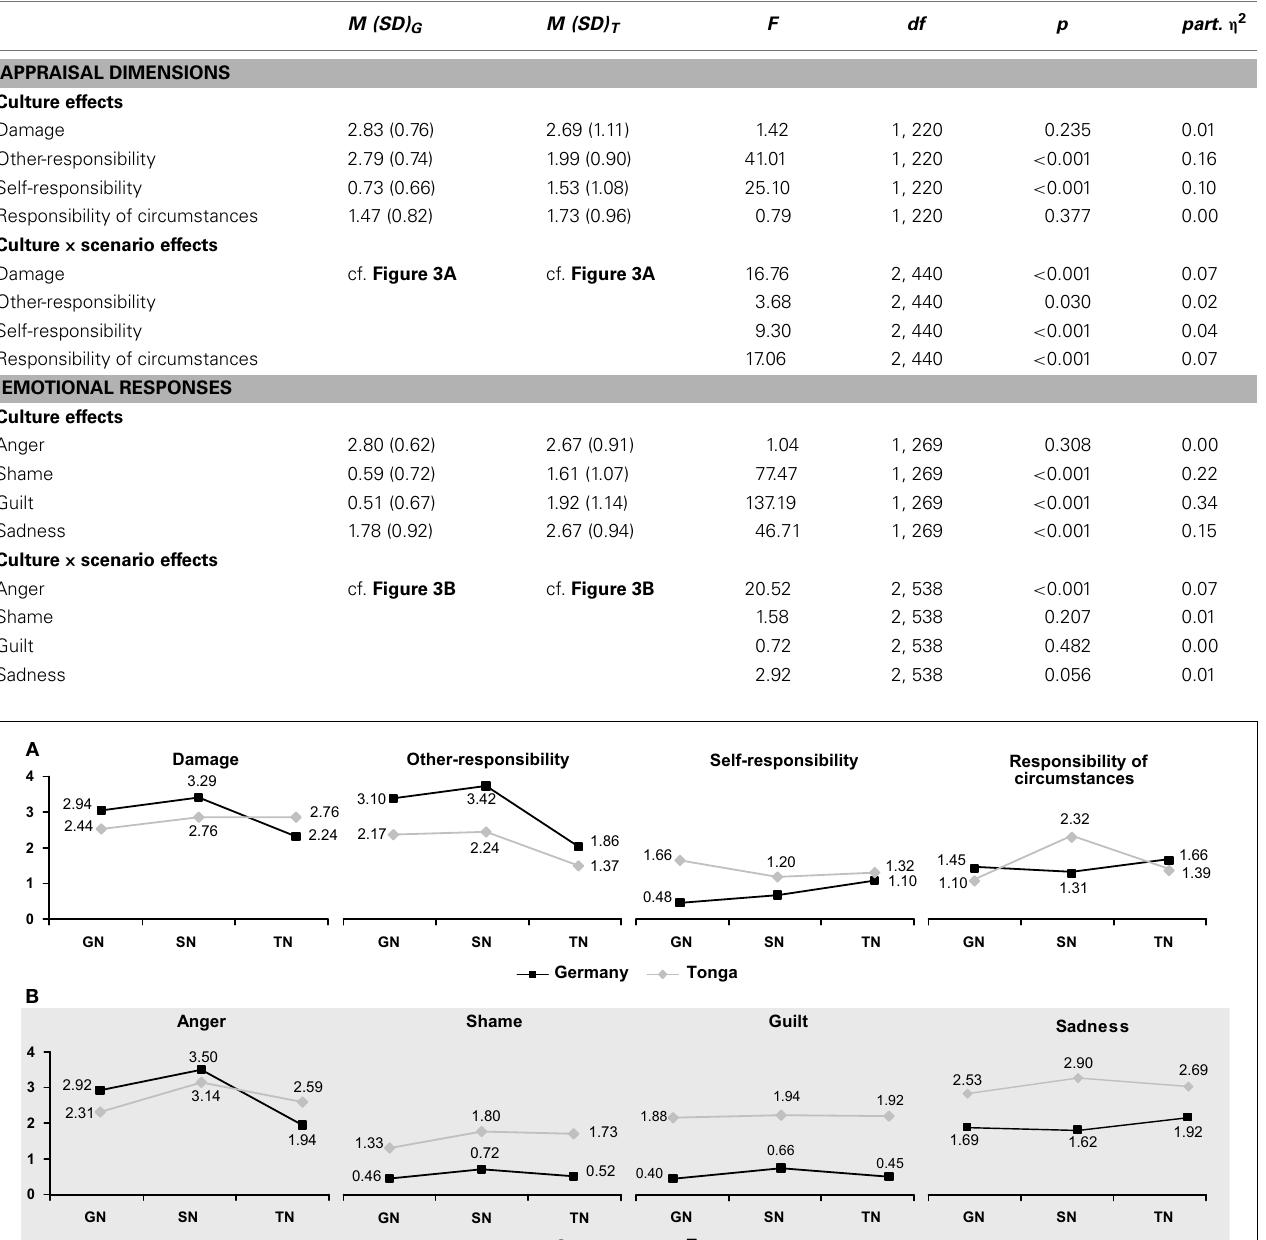
Table 2 | Univariate effects of (a) appraisal dimensions and (b) emotional responses for triplet 1 (GN, SN, andTN).